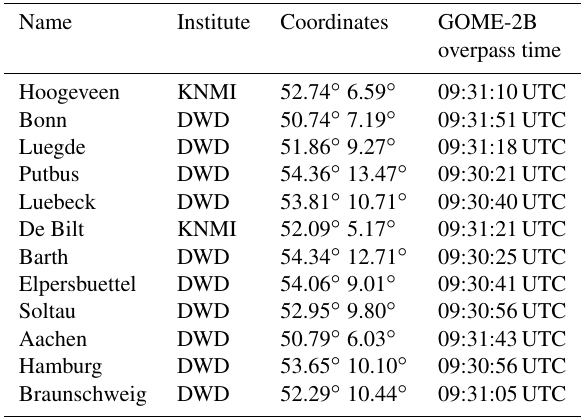
Table 4. Ceilometer stations in western Europe used for validating the retrieved z aer from GOME-2B for plumes from the 17 October 2017 Portugal